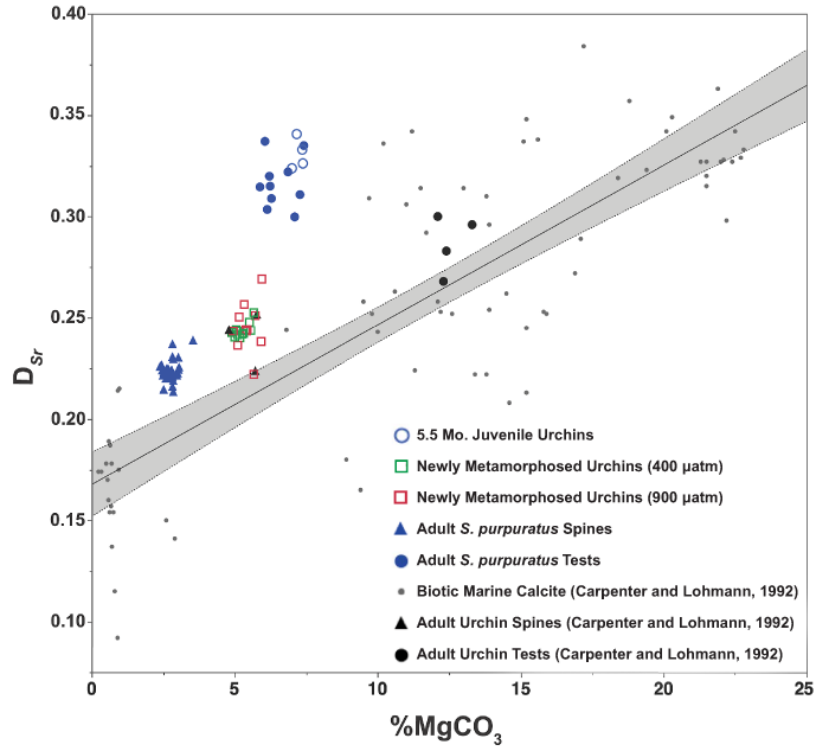
Fig. 3. The relationship between skeletal magnesium content (expressed as %MgCO 3 ; x-axis) and strontium partition coefficient ( D Sr ; y- axis) for S. purpuratus adult spines (blue filled triangles), adult tests (blue filled circles), 5.5-month-old cultured juvenile tests (open blue circles), and newly metamorphosed juveniles settled after 48–49days in culture at 400 (green open squares) and 900 (red open squares) µatm p CO 2 . Linear regression and 95% confidence intervals plotted in grey shading derived from biotic marine calcite (grey filled circles) including adult urchin spines and tests (black filled triangles and circles, respectively; Carpenter and Lohmann, 1992).